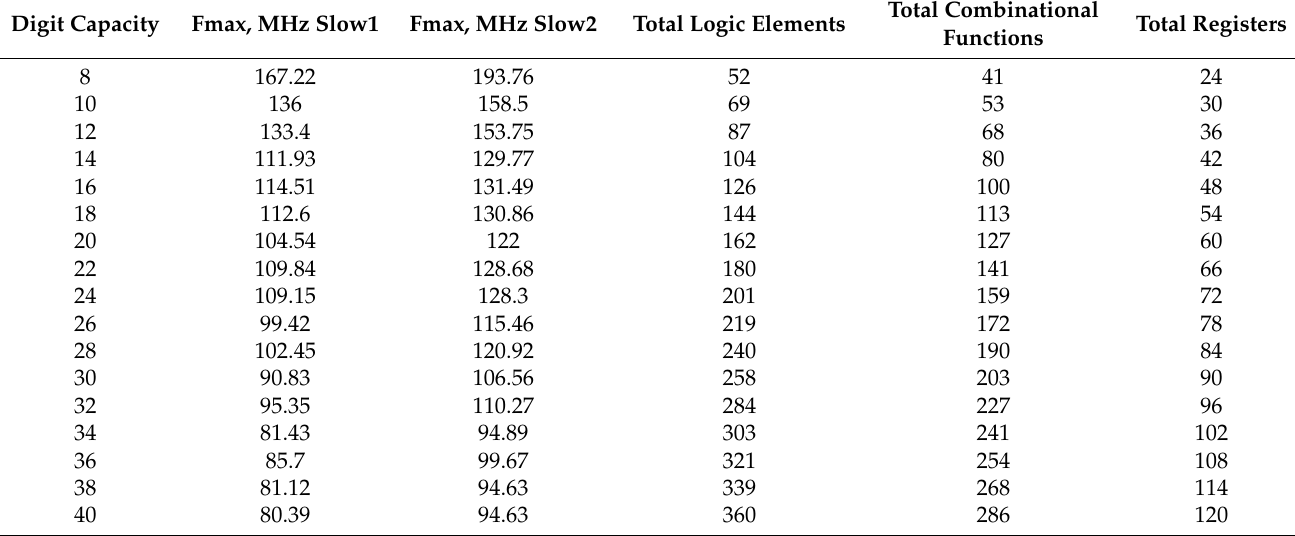
Table 5. Characteristics of a combinational multiplier per constant implementing the modified Booth algorithm.